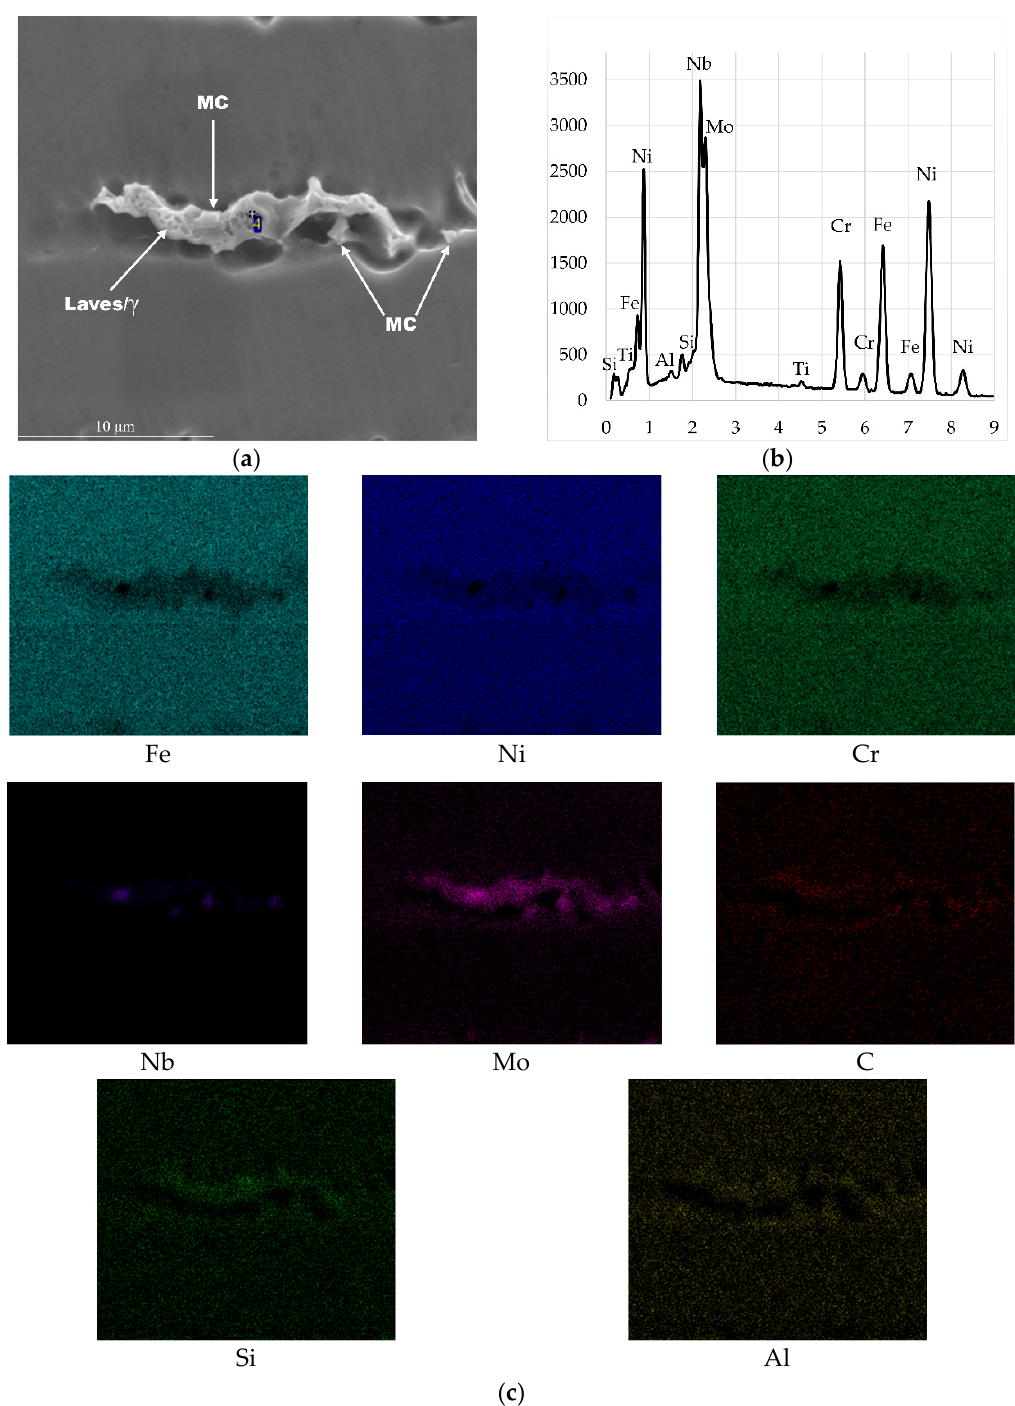
and austenite) in the transition zone of the substrate/clad for high dilutions levels.